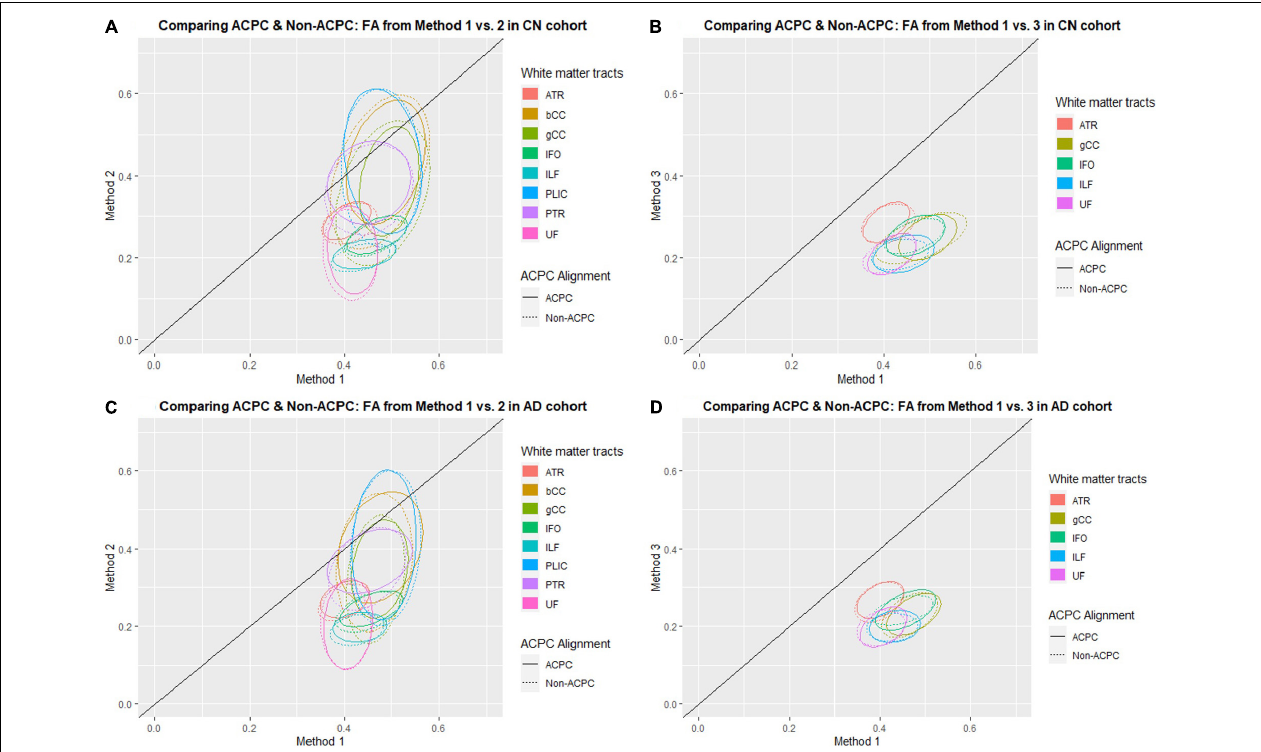
FIGURE 1 | Distribution of scatter plots of FA obtained using Methods 2 and 3 against Method 1, comparing non-ACPC aligned and co-registered with ACPC aligned white matter tracts across cognitively normal (CN) and Alzheimer’s Disease (AD) cohorts. The ellipses assume a multivariate normal distribution with the mean at the center and area of the ellipse representing 95% confidence level. gCC, genu of the corpus callosum; bCC, body of the corpus callosum; ATR, anterior thalamic radiation; IFO, inferior fronto-occipital fasciculus; ILF, inferior longitudinal fasciculus; PLIC, posterior limb of the internal capsule; PTR, posterior thalamic radiation; UF, uncinate fasciculus. (A) Comparing ACPC and Non-ACPC: FA from Method 1 vs. 2 in CN cohort. (B) Comparing ACPC and Non-ACPC: FA from Method 1 vs. 3 in CN cohort. (C) Comparing ACPC and Non-ACPC: FA from Method 1 vs. 2 in AD cohort. (D) Comparing ACPC and Non-ACPC: FA from Method 1 vs. 3 in AD